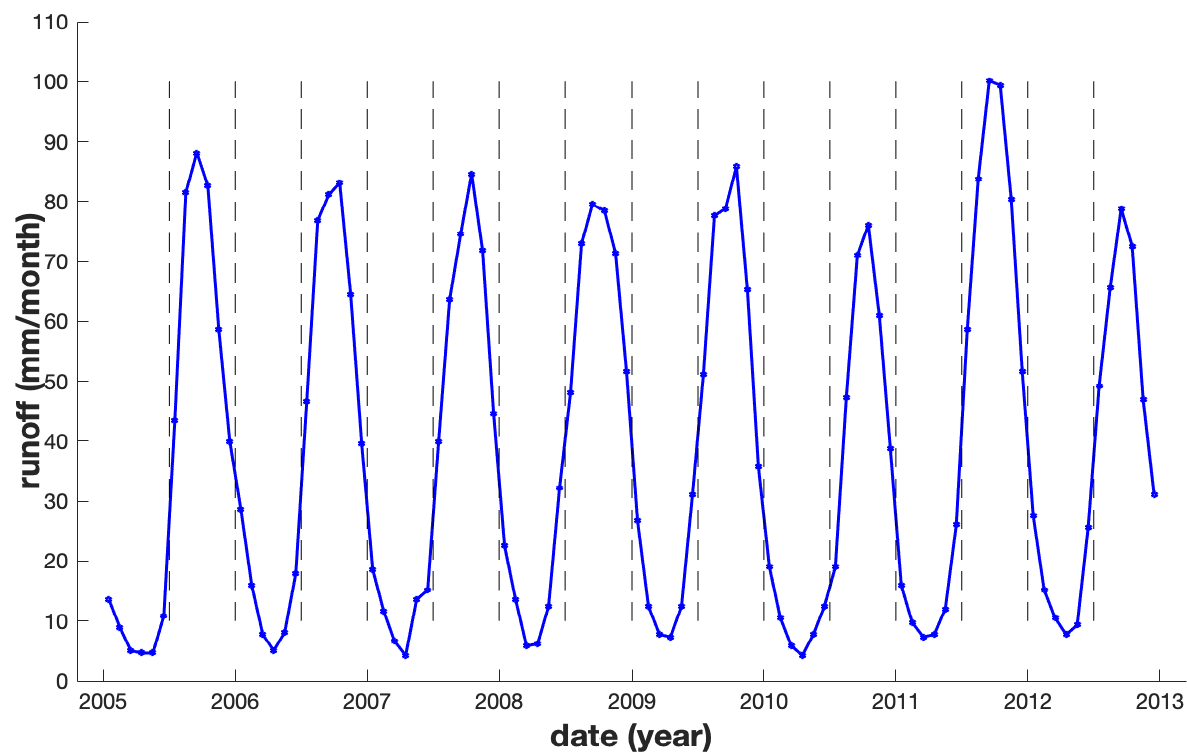
Figure 4. Monthly Mekong basin runoff measured at the Chau Doc and Tan Chau stations during 2005–2012.